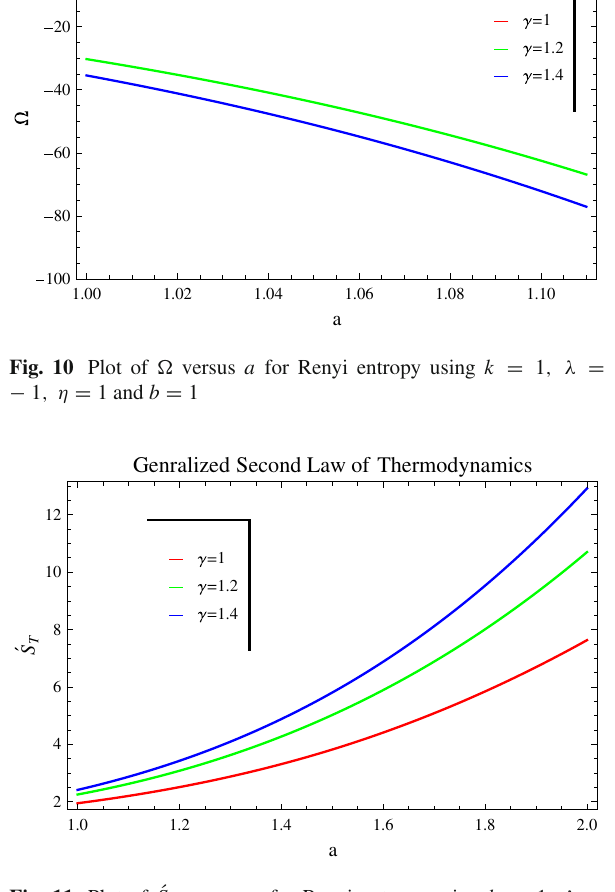
Fig. 11 Plot of ´ S T versus a for Renyi entropy using k = 1 , λ = − 1 , η = 1 and b = 1